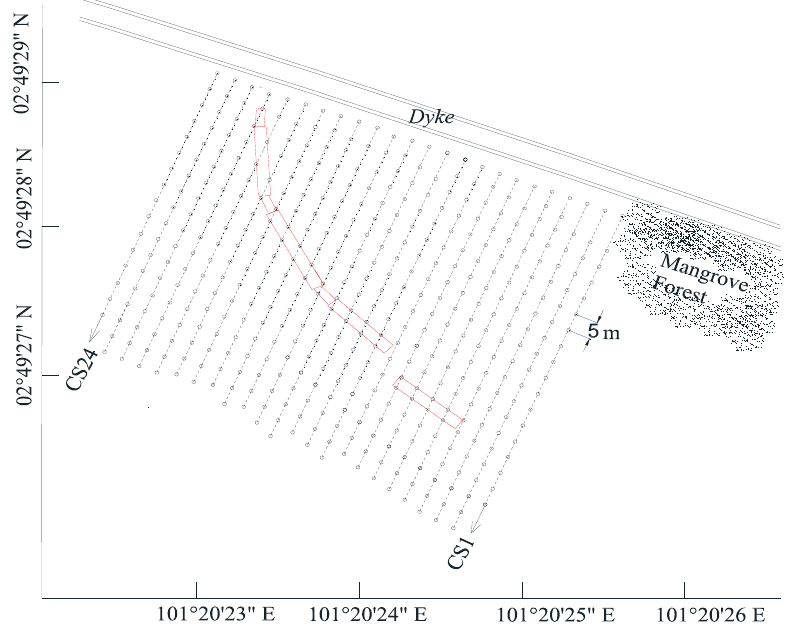
Figure 5. Bed profiling method in the study site (24 profiles).